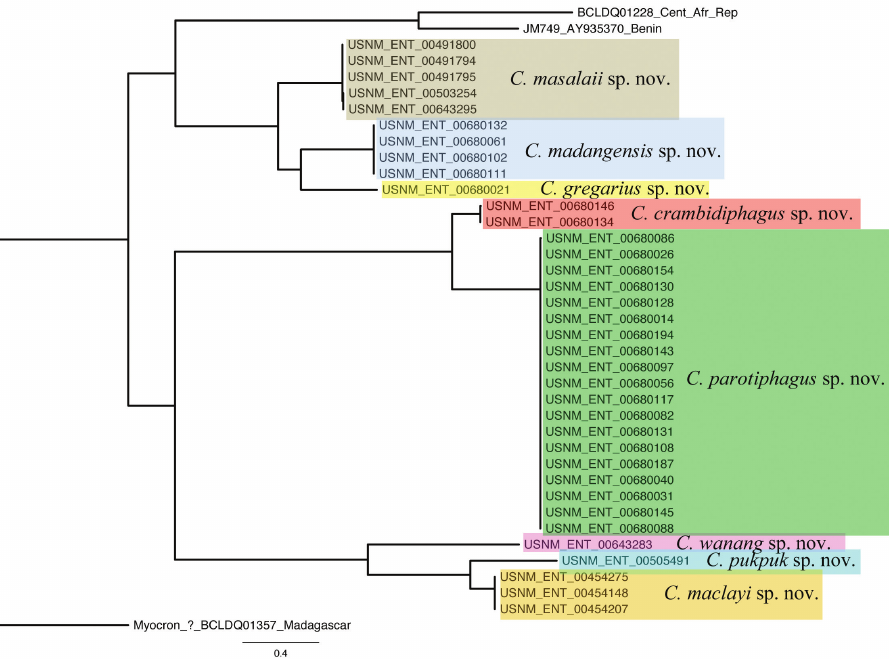
Figure 1. Maximum likelihood tree (using GTR+G parameter model) of the reared and barcoded species of Colastomion (final Gamma –based likelihood